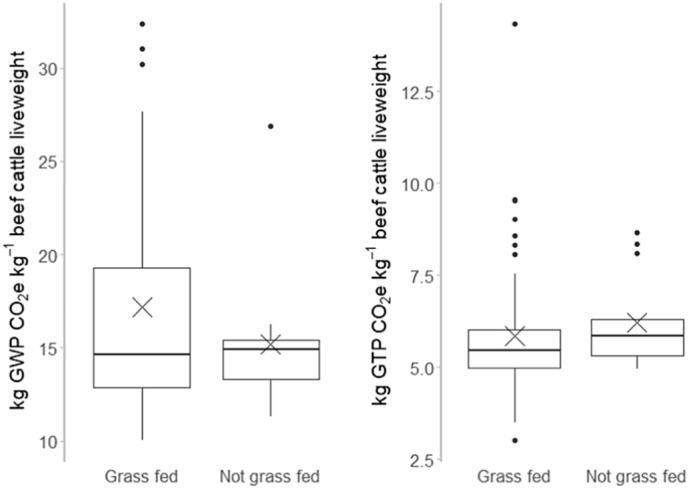
Grass fed and non-grass fed GWP100 and GTP100 CO2e footprints per kg beef cattle liveweight.